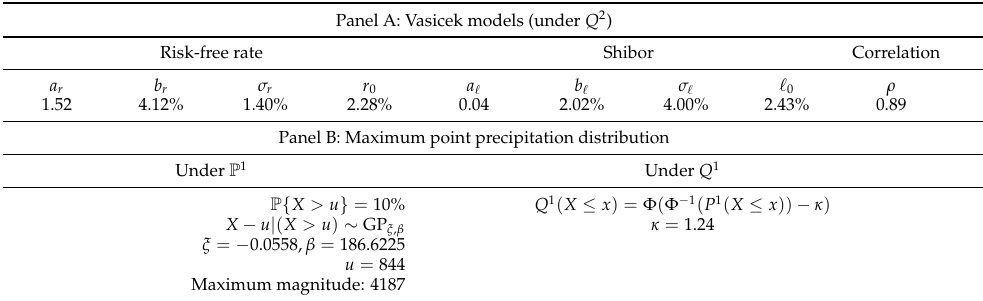
Table 4. Parameters of interest rate and precipitation modeling.